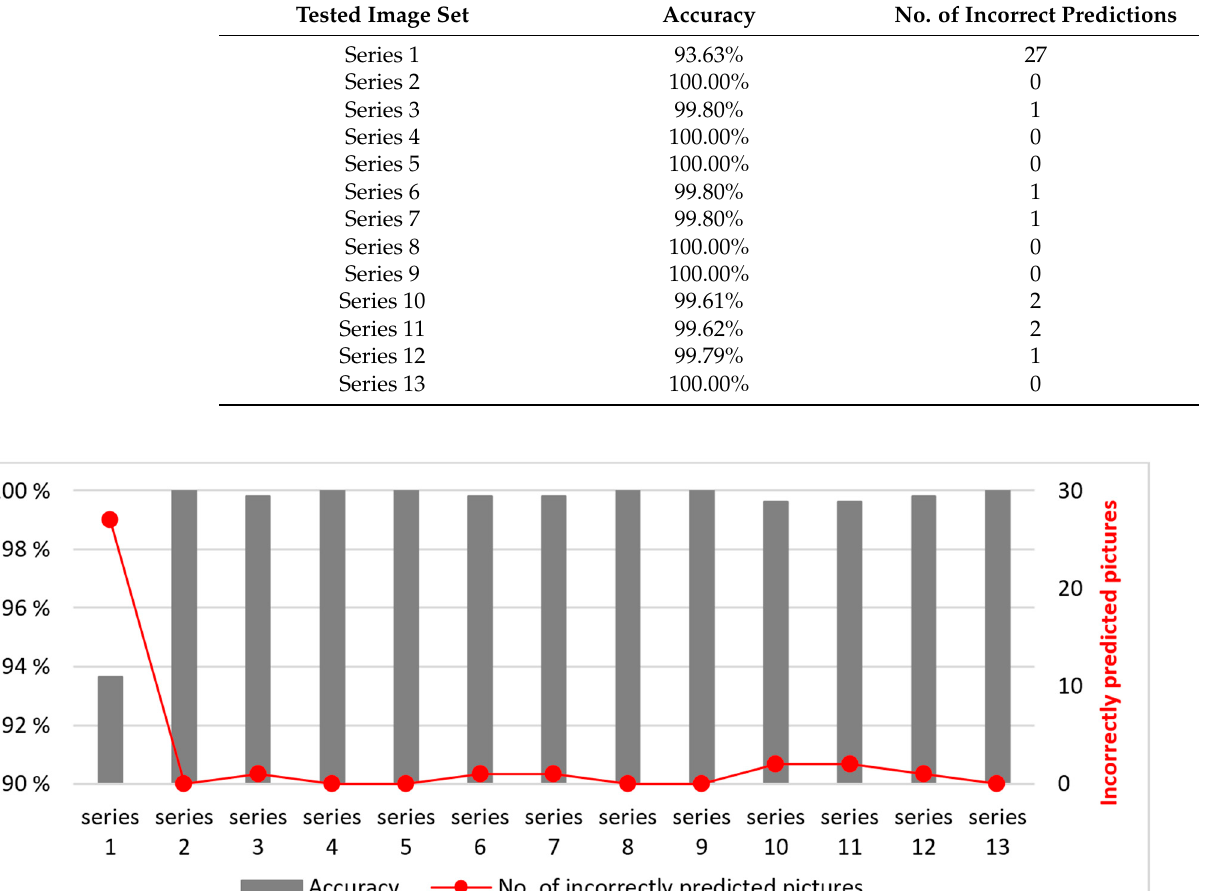
Table 12. The classification accuracy for each test set.